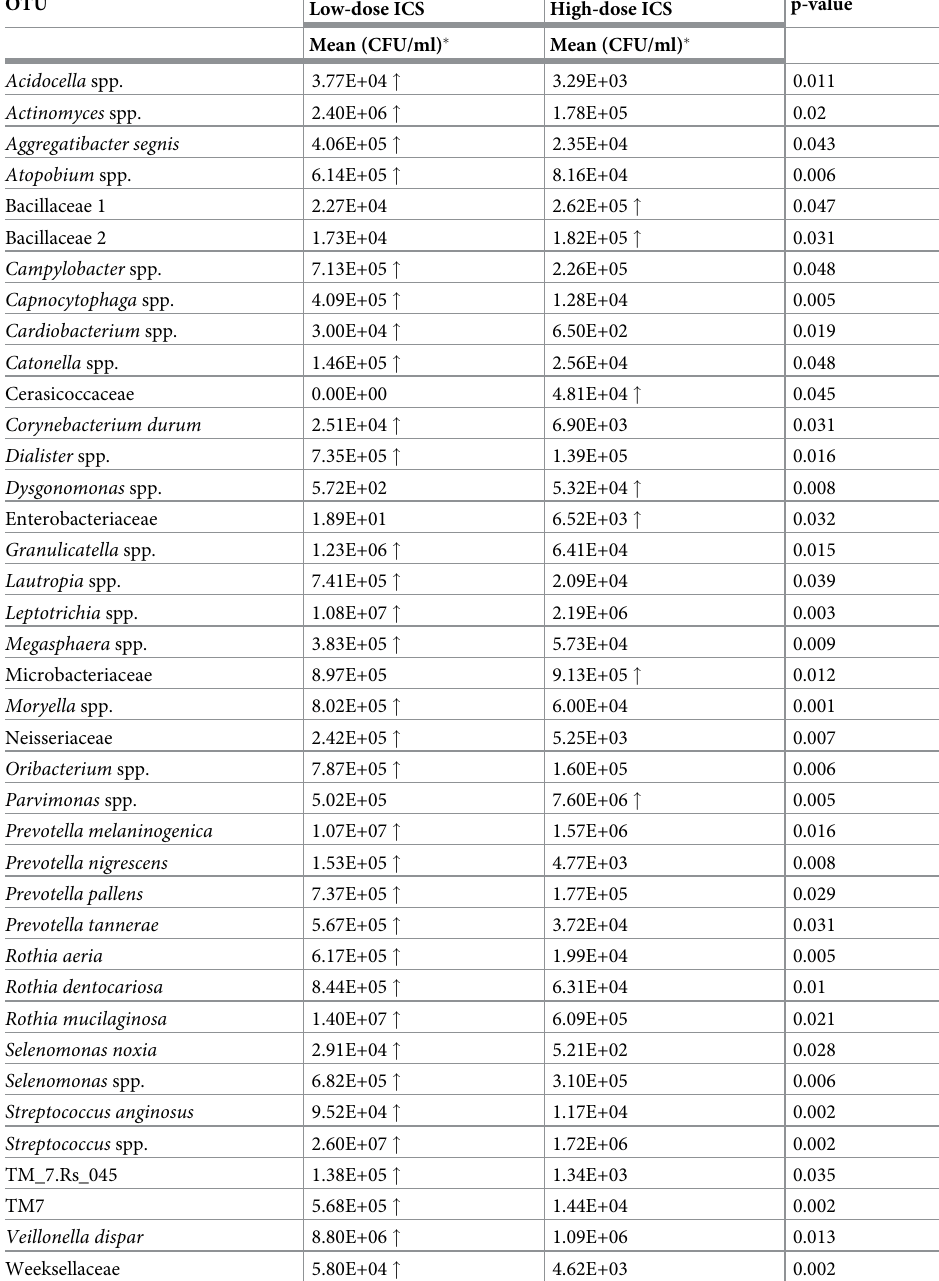
Group with highest comparative abundance of each OTU signified by " . � normalised OTU relative abundance (%) were multiplied by their corresponding qPCR-derived total bacterial load obtained from the qPCR data to give a CFU/ml